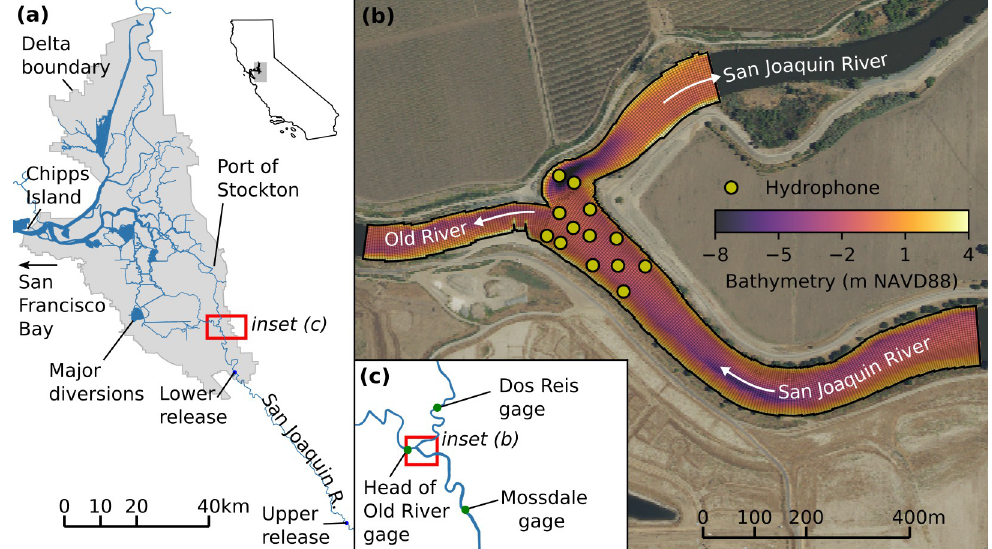
Fig 1. Study site. (a) Sacramento-San Joaquin Delta, including San Joaquin River and fish release locations. (b) Head of Old River study site, with computational grid and bathymetry, and the layout of the hydrophone array. White arrows show the downstream flow direction (noting that tidal flow reversal is possible on the downstream section of the San Joaquin River). (c) Location of gages relative to study